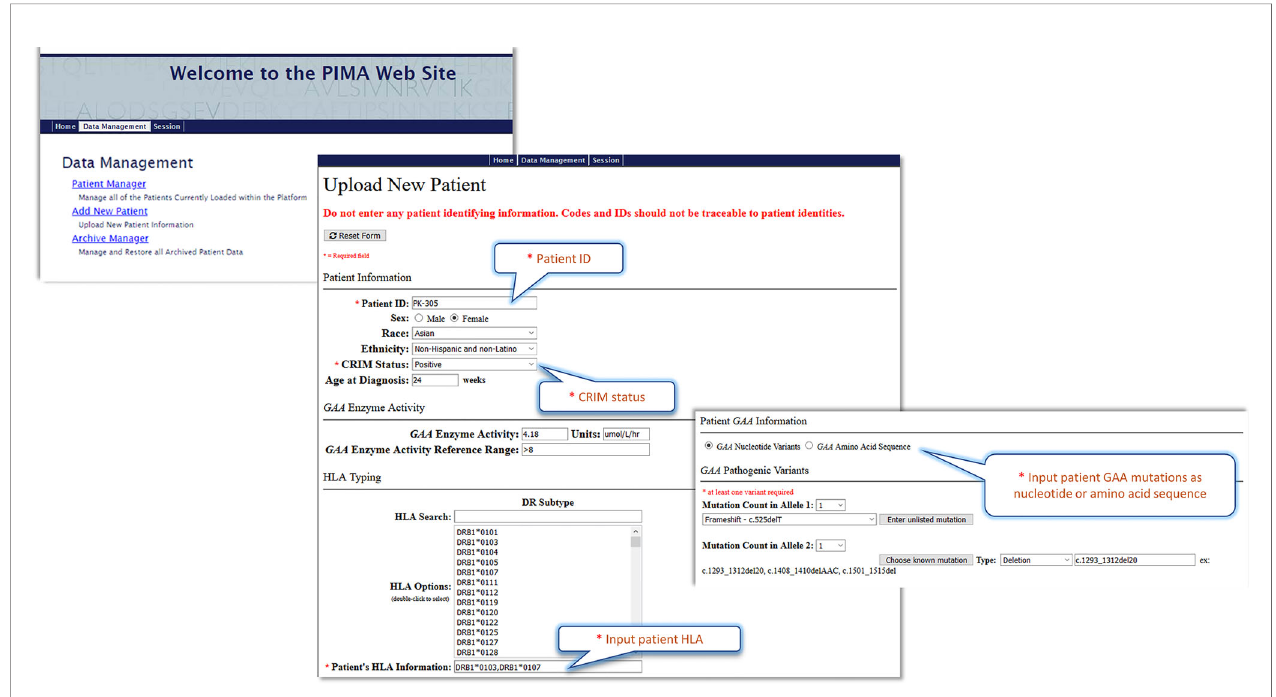
FIGURE 7 | The Pompe PIMA user interface prototype. The upper screenshot shows the Pompe PIMA homepage with data management options. The lower two screenshots from the Upload New Patient page feature the required (*) input fi elds to generate the IOPD patient ’ s individualized ADA risk assessment